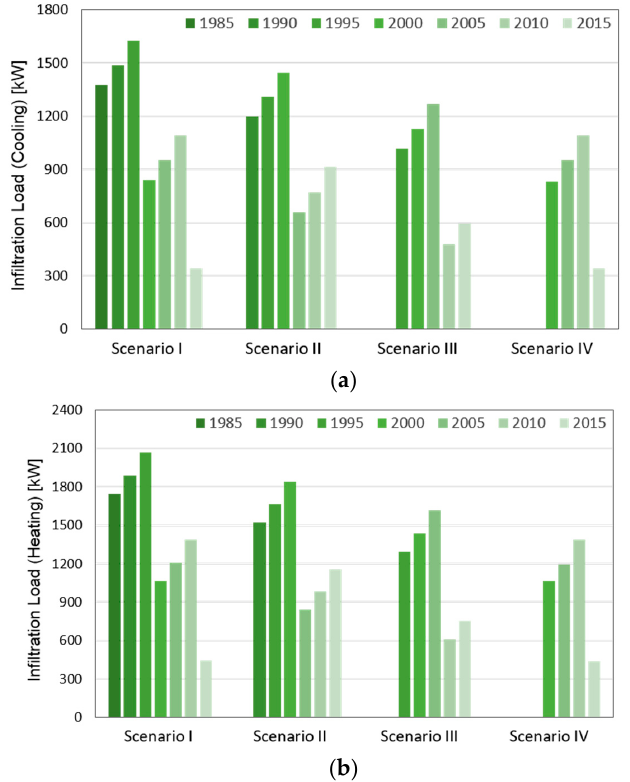
Figure 6. ( a ) is changes in the load of infiltration per scenario in cooling period, while ( b ) is the result in heating period.